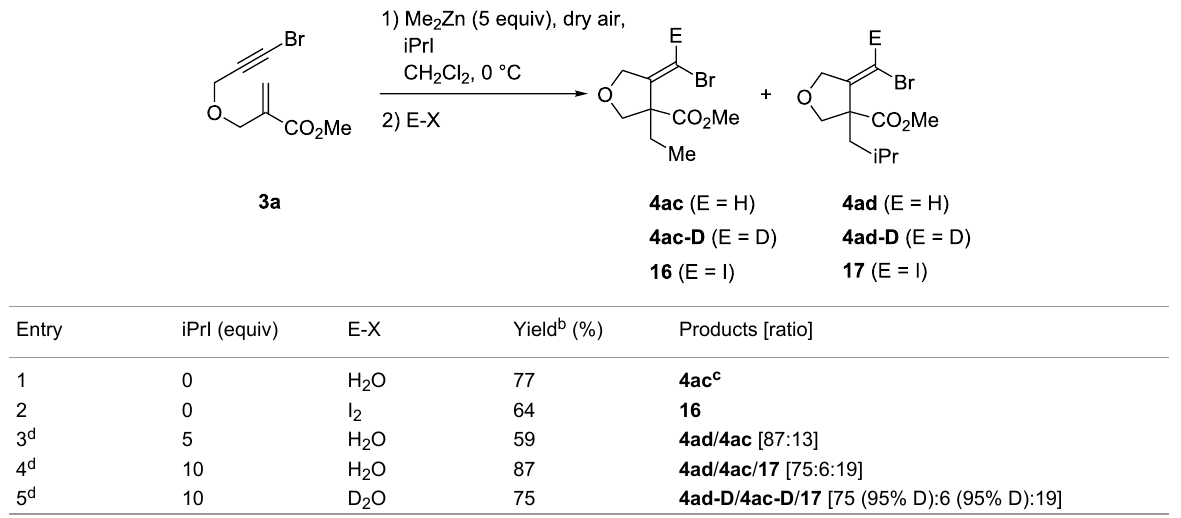
(Table 1): Under argon, to a stirred solution of β